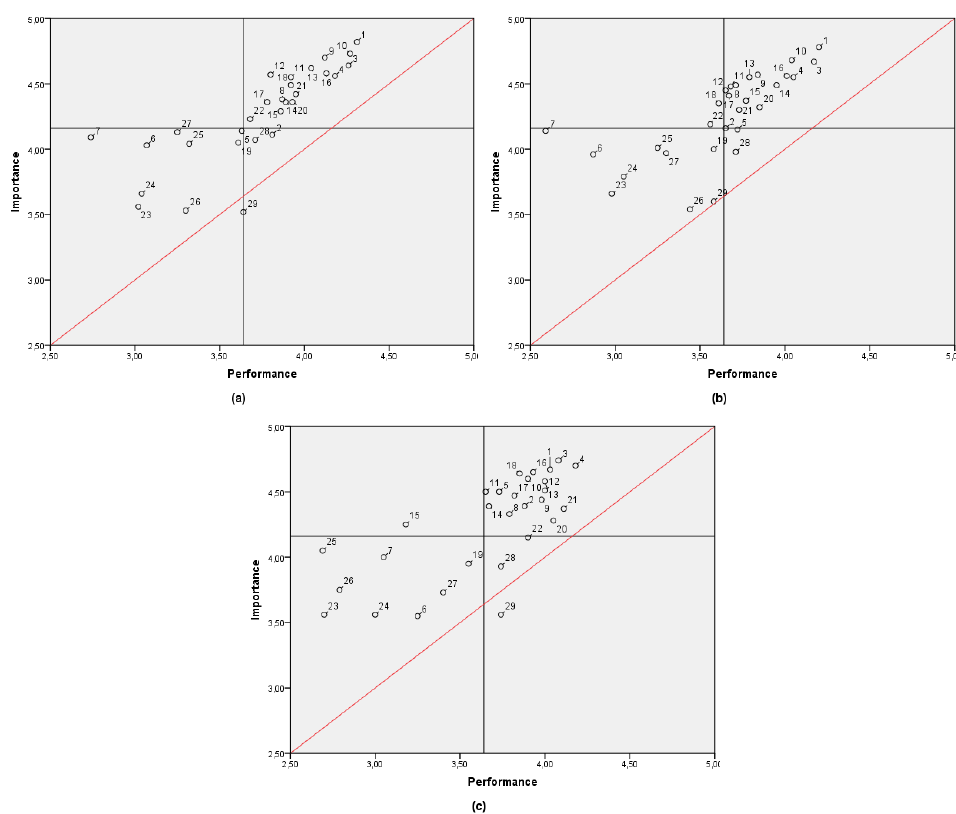
Figure 4. IPA matrix comparison by age: ( a ) 18 to 29; ( b ) 30 to 49; ( c ) 50 to 77. Table 4. Age correlation with importance and performance